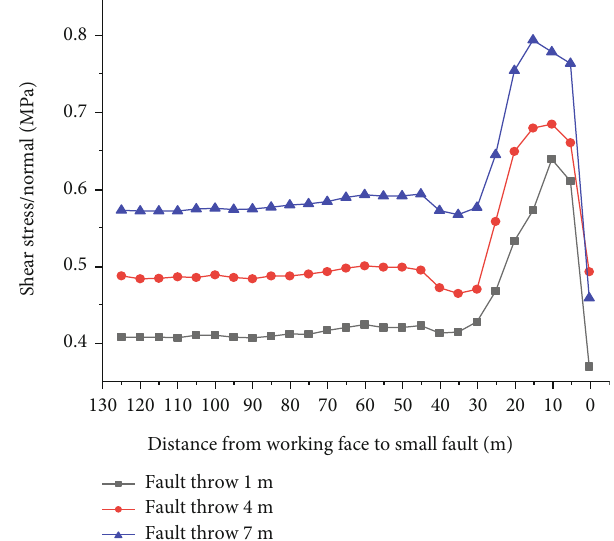
Figure 5: In fl uence of small fault drop on unsteady fault slide. The black dotted line represents a fault throw of 1 m, the red dotted line represents a fault throw of 4m, and the blue dotted line represents a fault throw of